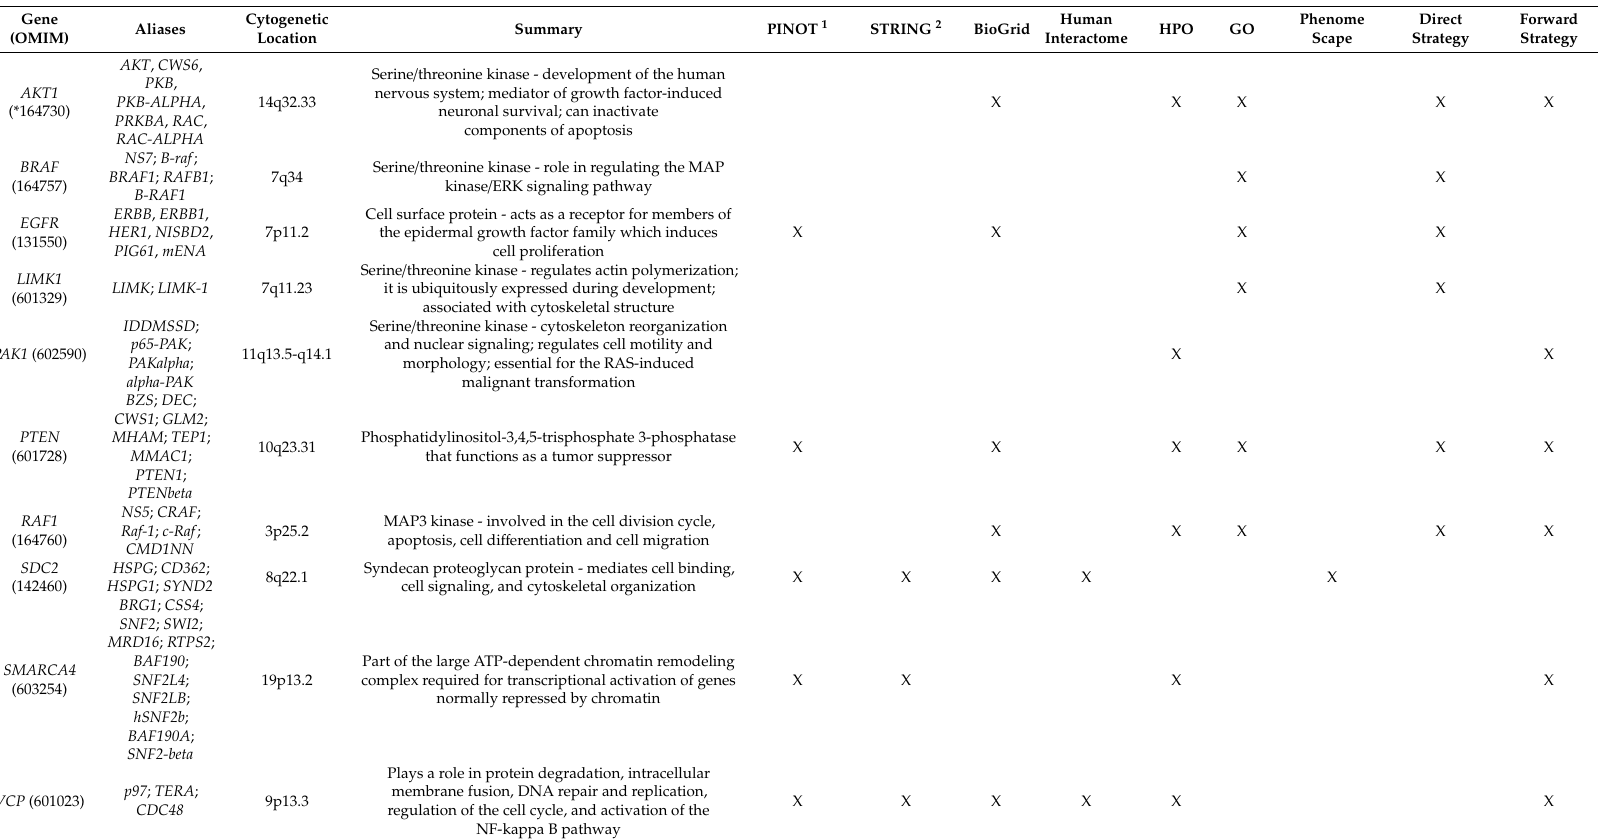
Table 1. Potential phenotype-modifier genes selected in this study. Characterization of the 10 potential phenotype-modifier genes and the approaches used for their